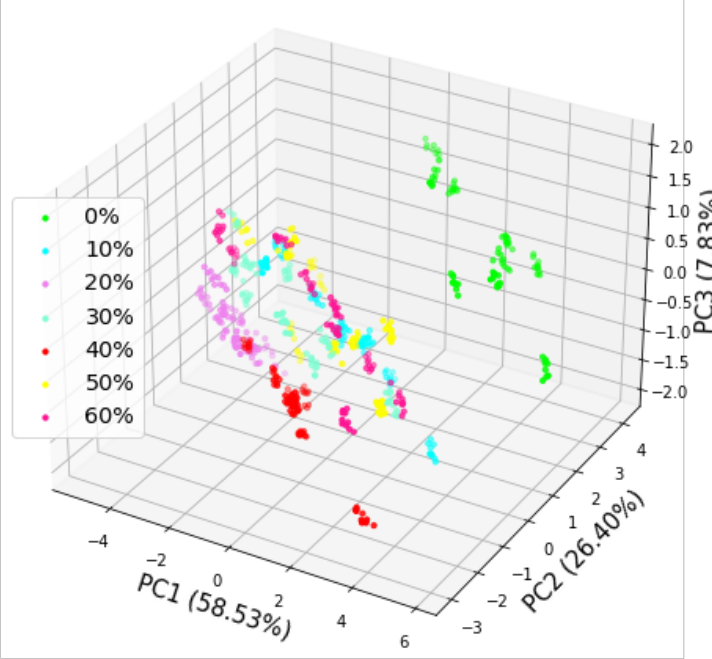
Figure 5. Projection of the first three principal components of the PCA of the meat